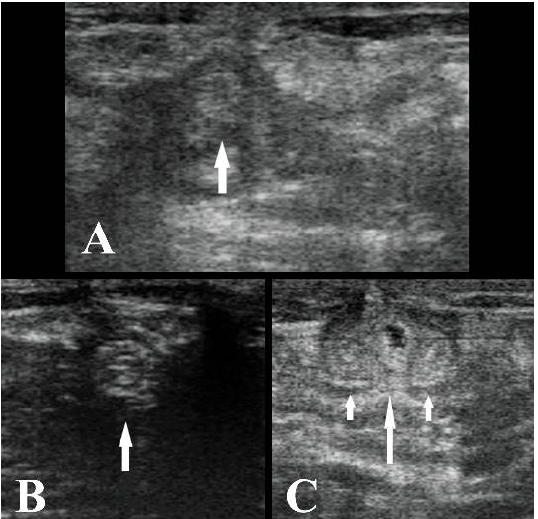
Figure 2. ( A ) Ultrasound image of the umbilical vein cranial to the umbilical stump at T1 (white arrow), transverse section. ( B ) Ultrasound image of the umbilical vein at the xiphoid cartilage at T1 (white arrow), transverse section. ( C ) Ultrasound image of the urachus (big white arrow) and left and right arteries (small white arrows) at T1, transverse section. The left side of the images is left, and the right side is right. B-mode, linear probe 7.5 MHz.